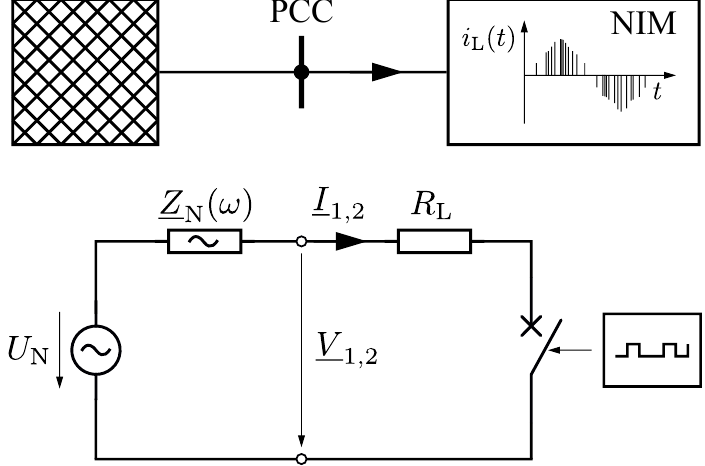
Figure 1. Principle of the network impedance measurement/identification.